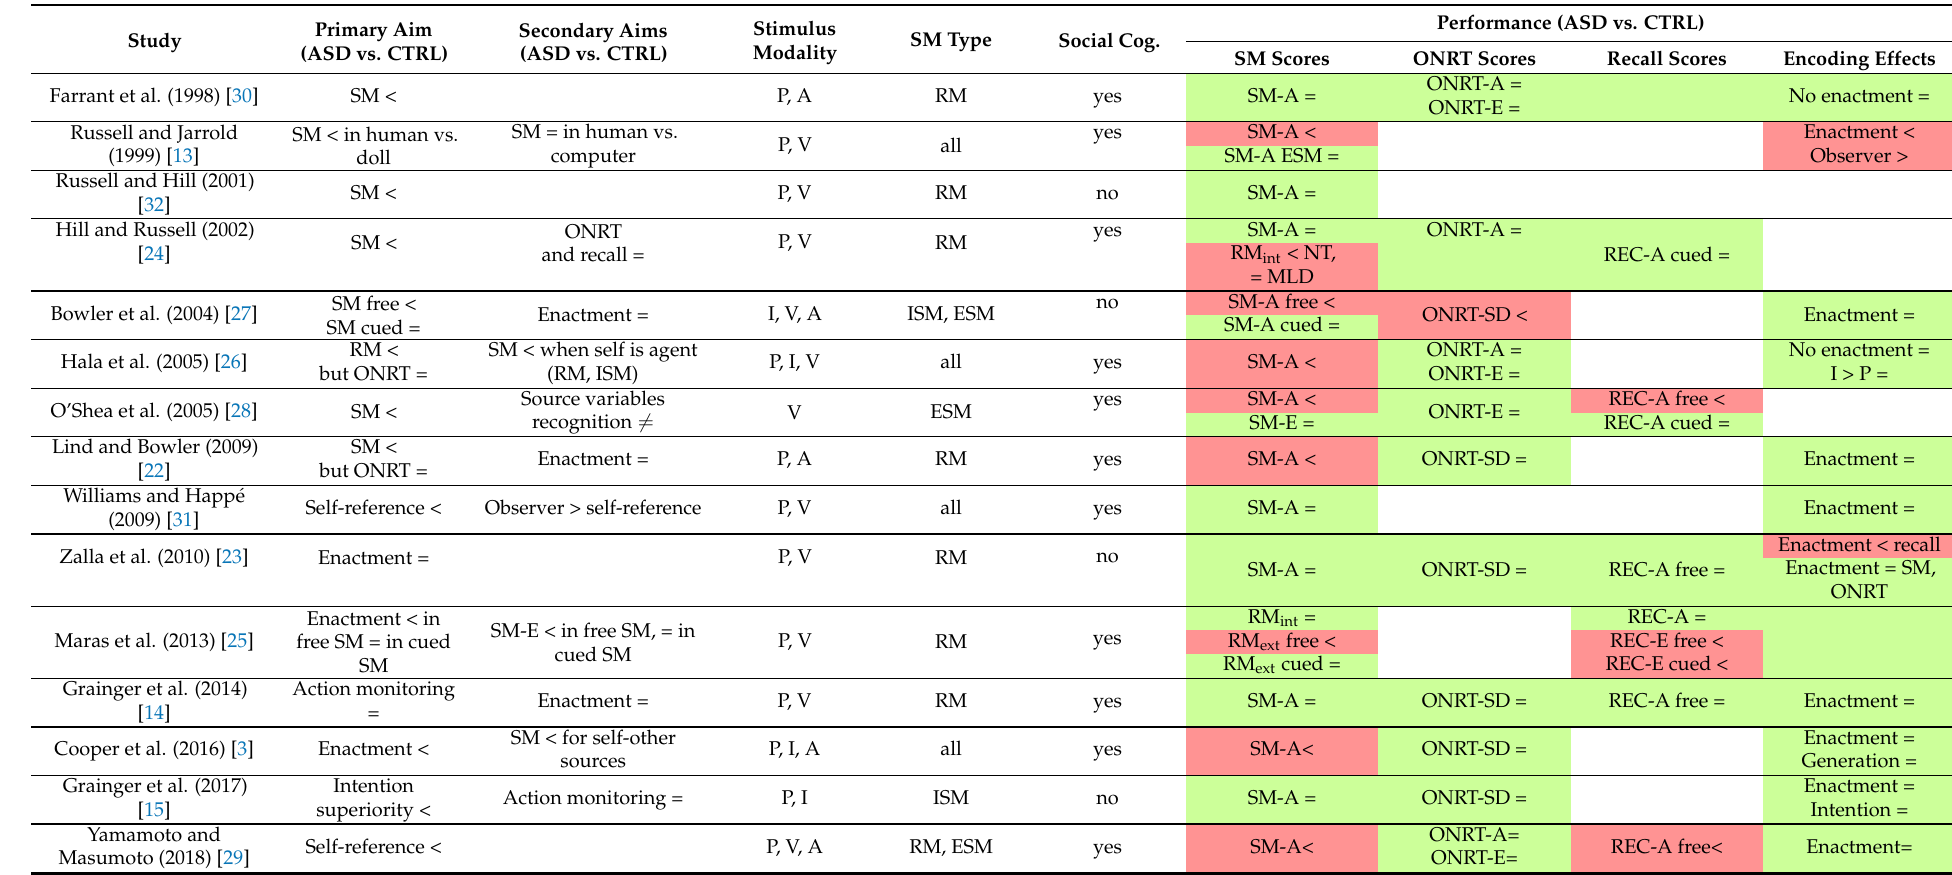
Table 2. Study aims and